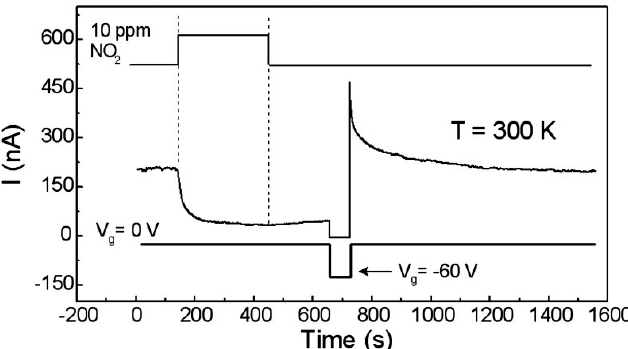
Figure 7. The response of the nanowire to 10 ppm NO refresh the surface of the nanowire at room temperature. Reprinted from reference [87] with permission from AIP